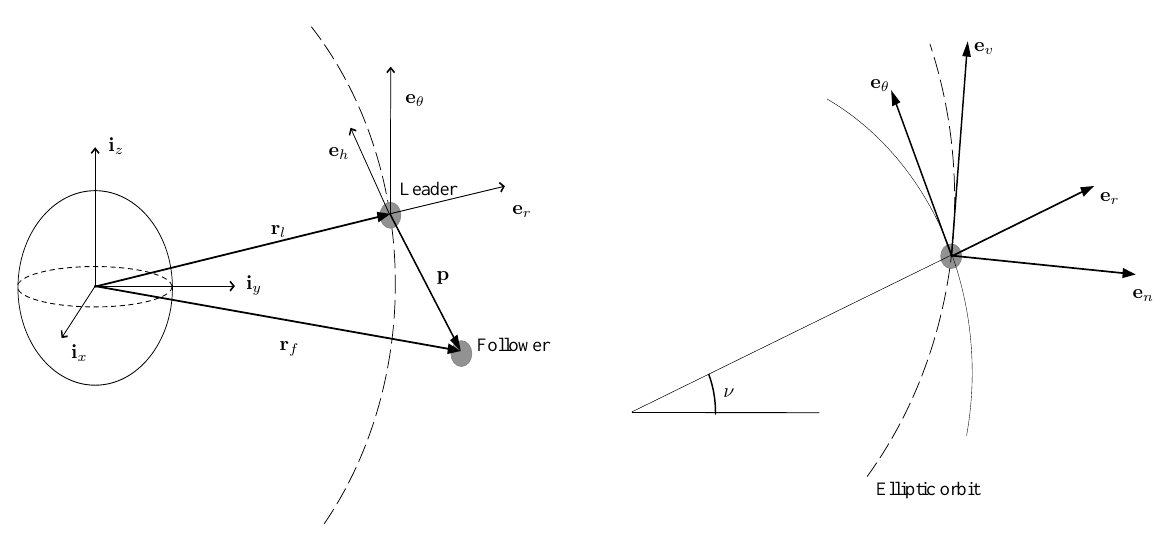
Figure 2: Auxiliary vectors for the leader orbit reference frame (Schaub and Junkins,